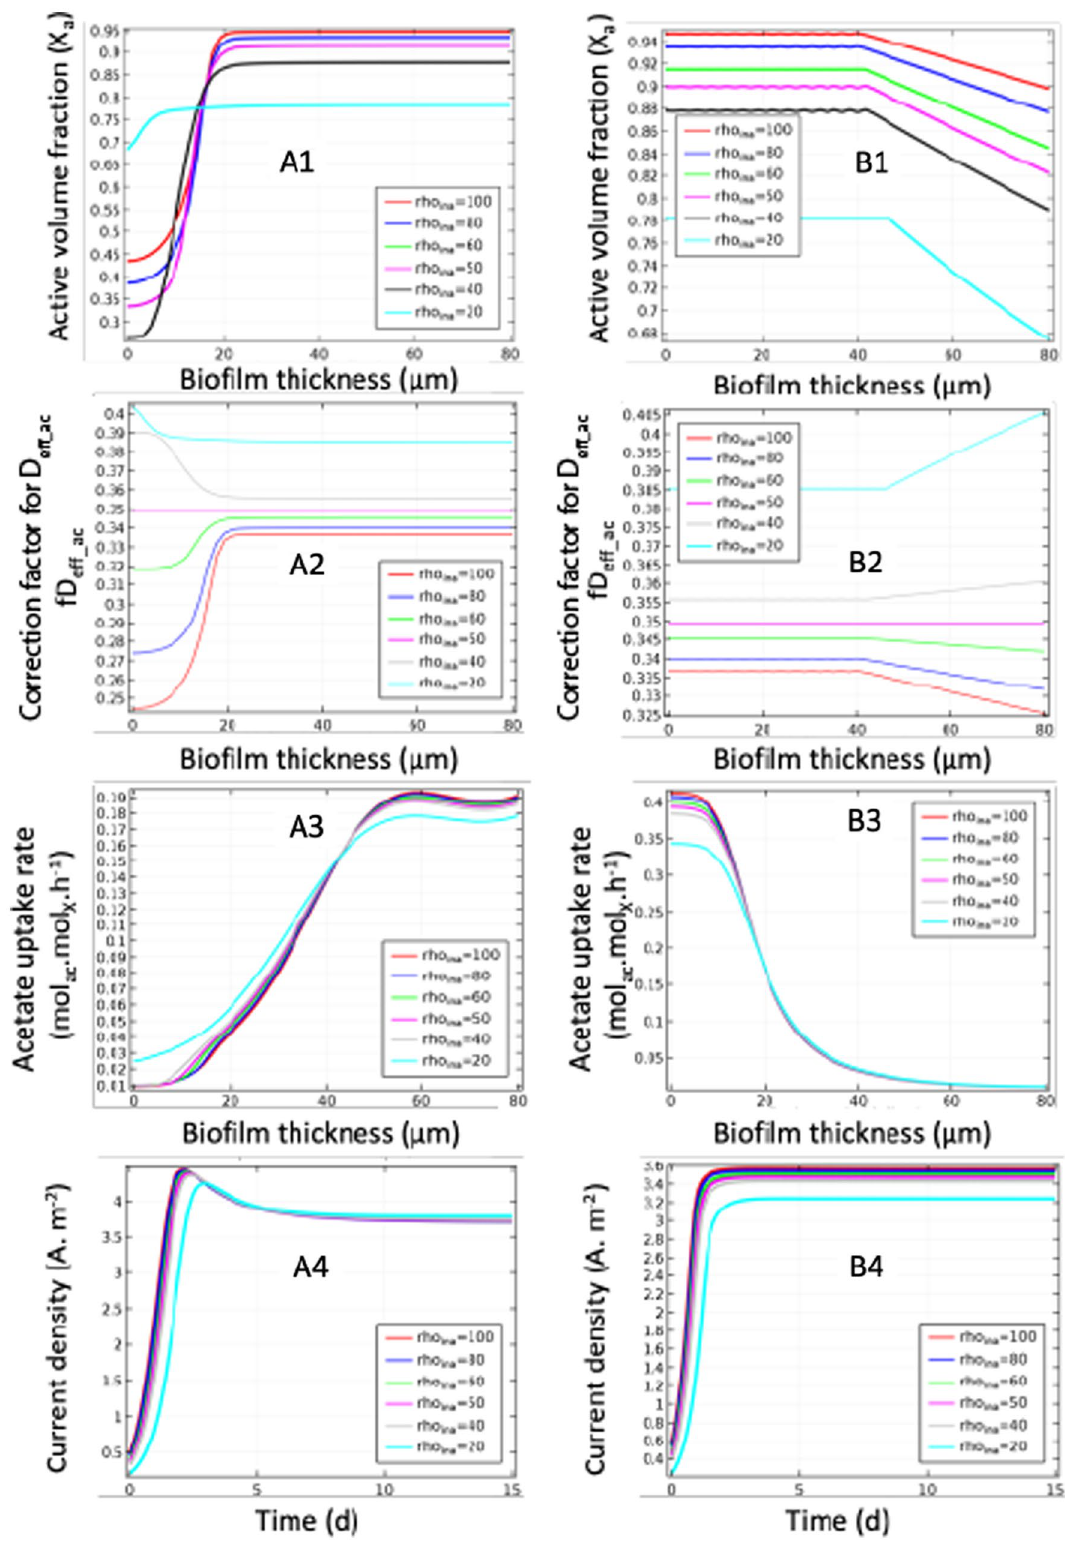
Figure 5. Simulations of inactive biomass density influence (rho ina = ρ ina in g.L -1 ) on biofilm performance. A1 to A4: results for limitation by diffusion; B1 to B4: results for limitation by conduction (EET) with 1: active volume fraction; 2: correction factor for D eff . ac (fD eff . ac ); 3: Acetate uptake rate, all vs biofilm thickness; 4: current density vs